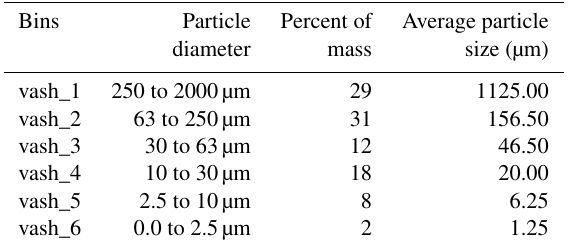
Table 1. Volcanic ash particle size distribution and ash bins property for LOTOS-EUROS model